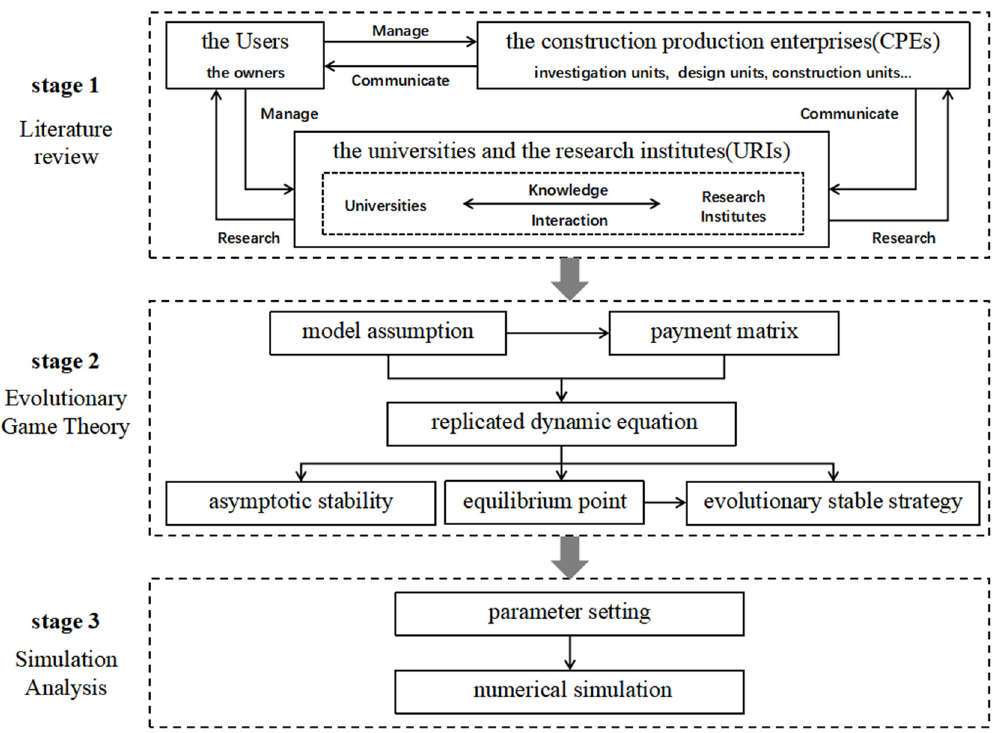
Figure 1. Research flowchart.